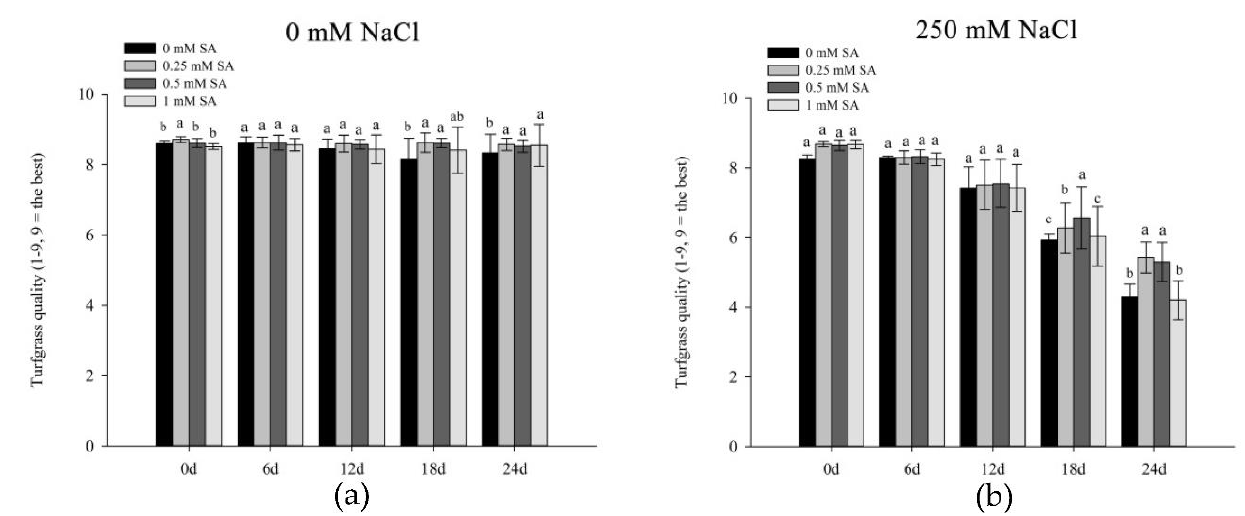
Figure 1. Effect of salicylic acid on turfgrass quality of perennial ryegrass under control ( a ) and 250 mM salt stress ( b ) conditions. The different letters indicate significant differences ( p ≤ 0.05). Salt stress reduced the Chl content relative to the control at 12, 18, and 24 d (Figure 2). The application of SA at 0.25 mM alleviated the Chl content decline in salt-stressed plants at 6, 12, 18, and 24 d. The SA treatment at 0.25 mM increased the Chl content by 27% relative to the non-SA treatment under salt stress at 24 d. No difference in the Chl content between the 1 mM and 0 mM SA treatments was found under salt stress.